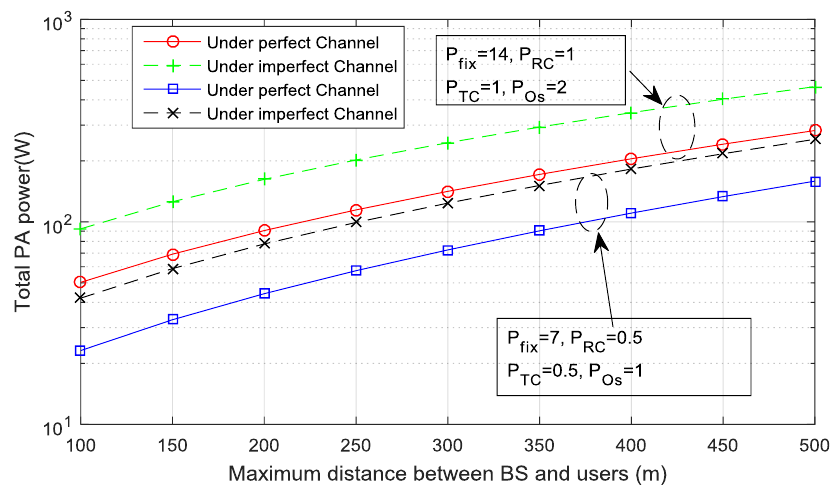
Figure 8. Optimal Power of non-linear amplifiers.